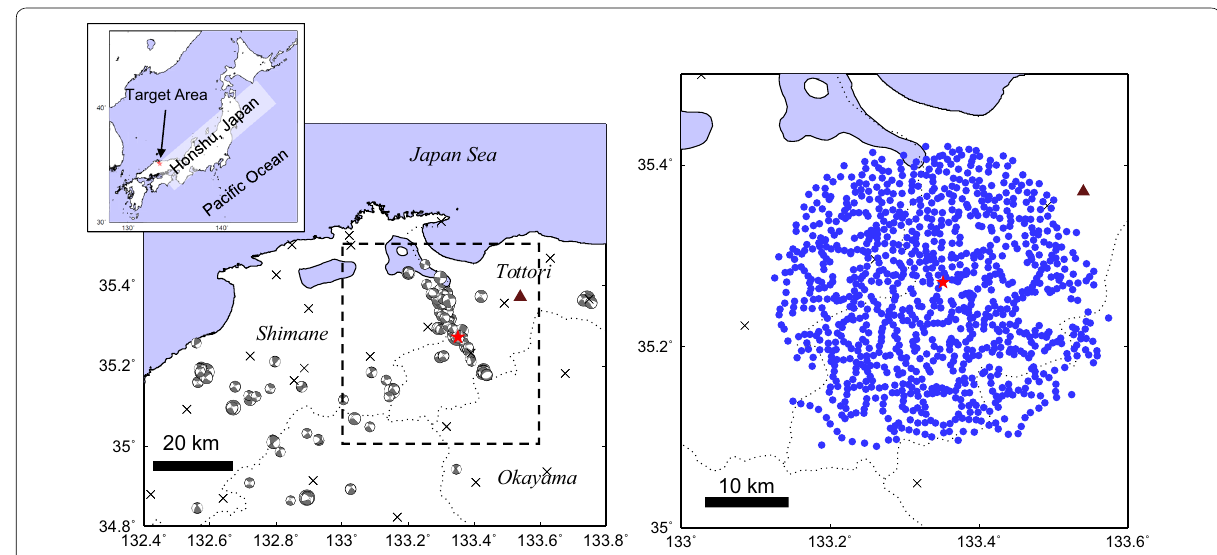
Fig. 1 Left) Target area and moment tensor solutions since the 2000 Western Tottori Earthquake, until Apr 2018, recorded by F-net, NIED. The beach balls show the moment tensor solutions plotted on the lower hemisphere. Crosses show Hi-net and NIED stations used in this study. Triangle indicates an active volcano. The red star indicates the epicenter of the main shock. Dotted lines indicate prefectural boundaries in the region. Right) Station distribution of the “0.1 Manten” dense seismic observations in blue circles. The location of the right map corresponds to the dashed rectangle in the left figure. Other symbols are the same as in the left